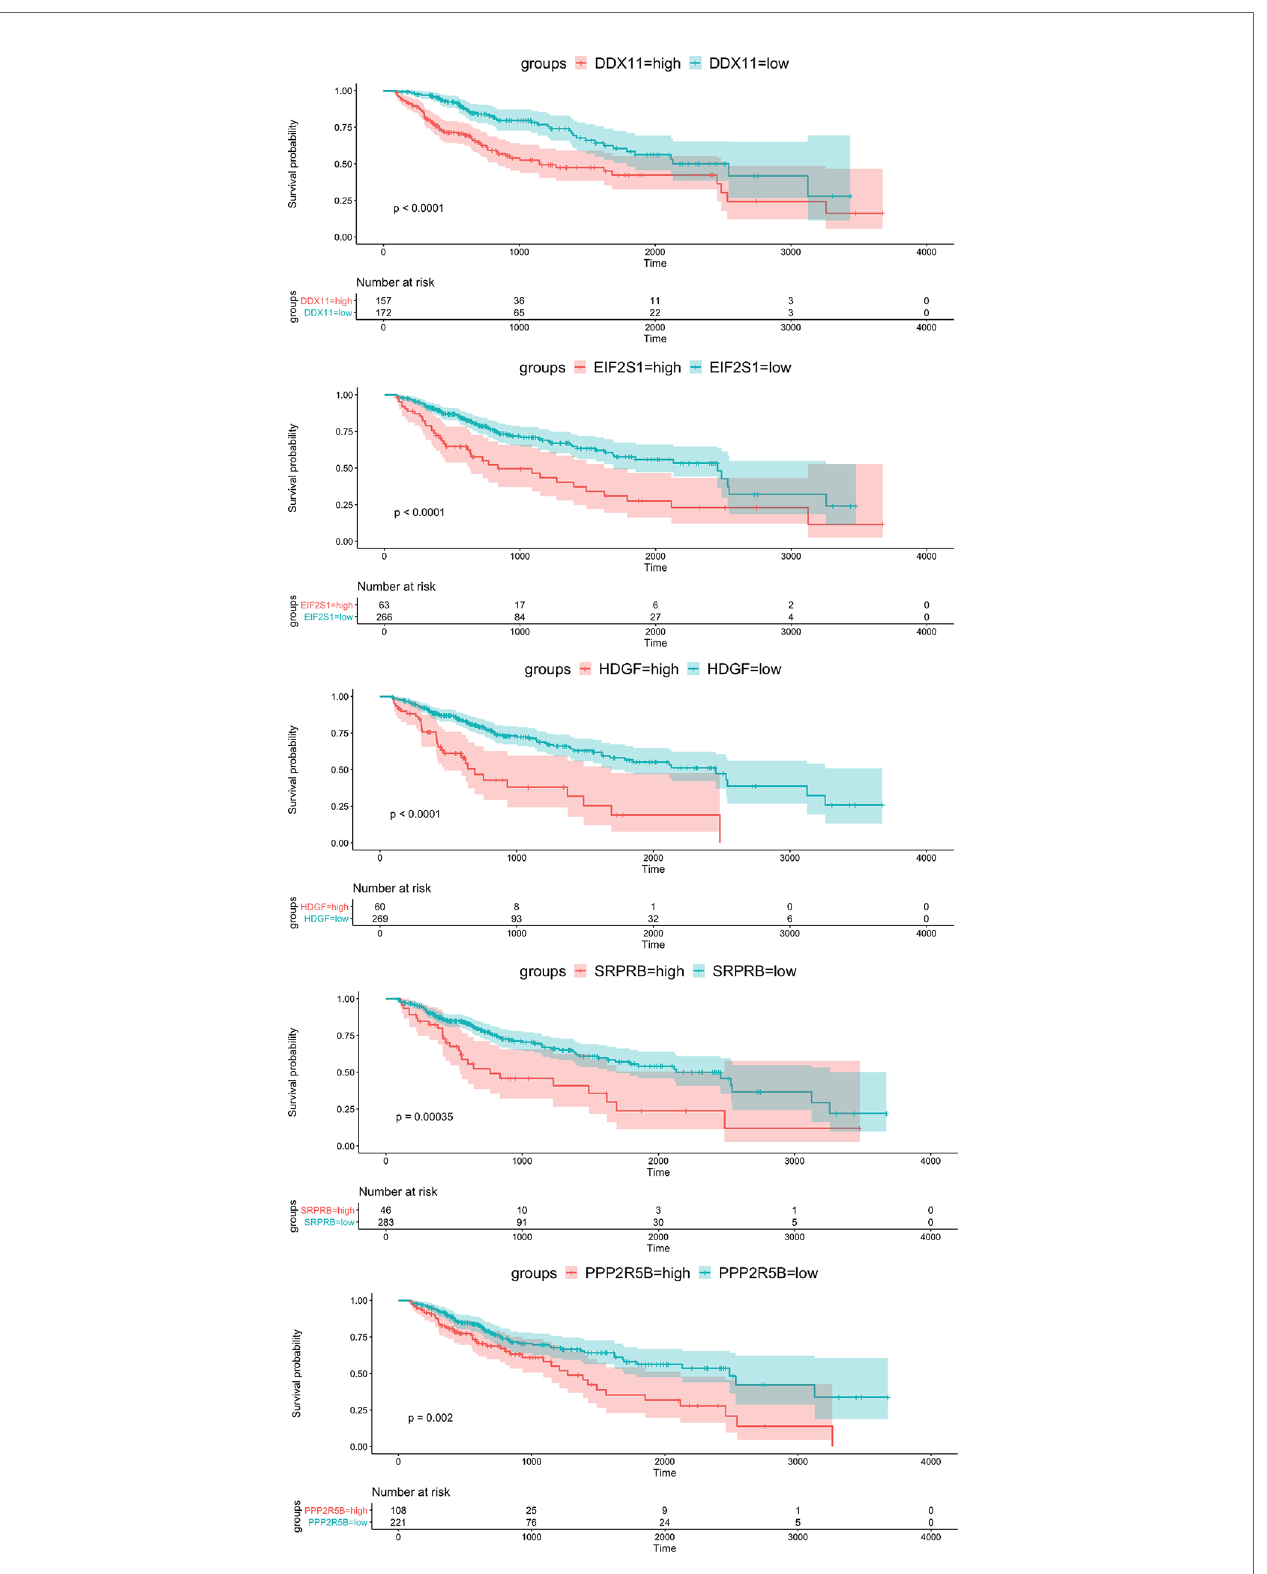
FIGURE 3 | Kaplan-Meier survival curve of OS for 5 hub genes with survival signi fi cance in the TCGA cohort. Red and green colors represent high and low expression, respectively.